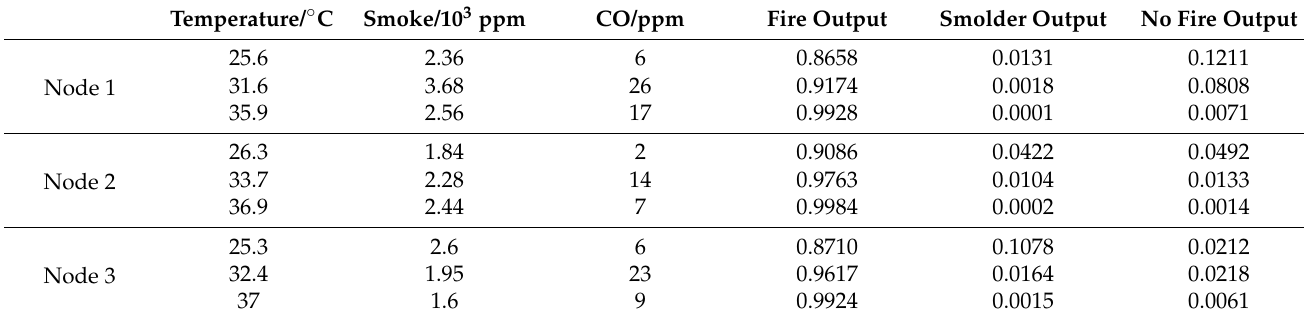
Table 11. The D-S evidence theory fusion